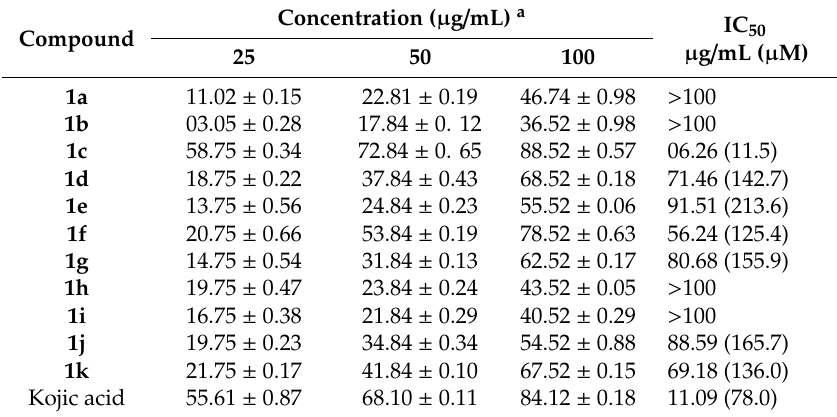
Table 2. The compounds ( 1a – 1k )—Tyrosinase